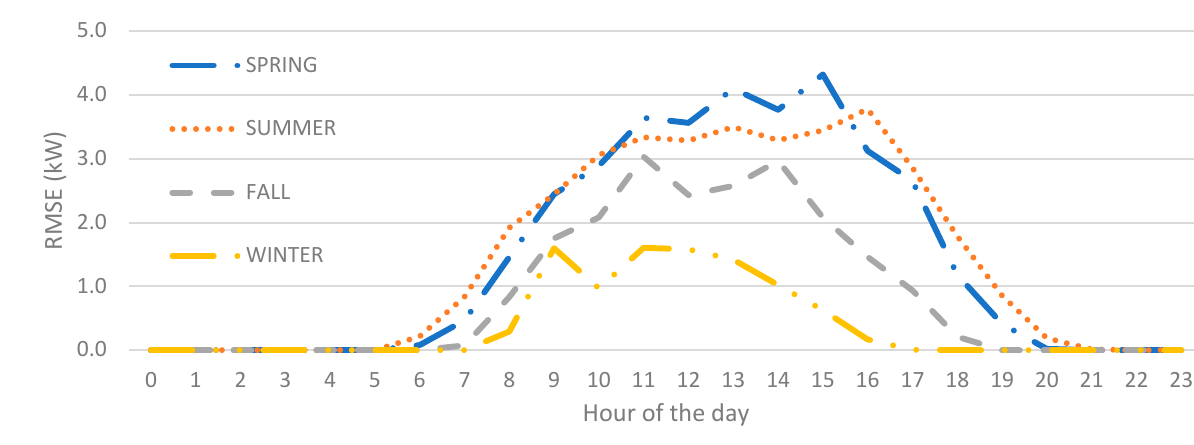
Figure 7. Average RMSE for each hour of the day for the proposed Model S1M.